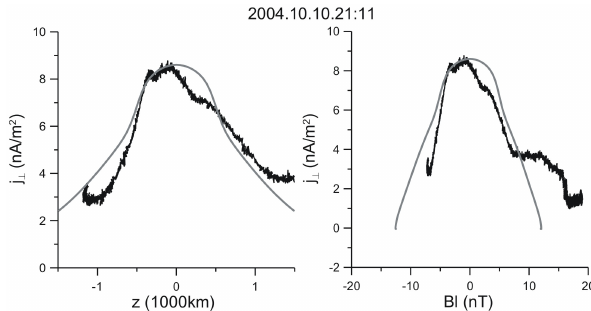
Fig. 9. Comparison of experimental (black) and model (grey) cur- rent density profiles w.r.t. coordinate along the normal and magnetic field component B l . Case 10 October 2004